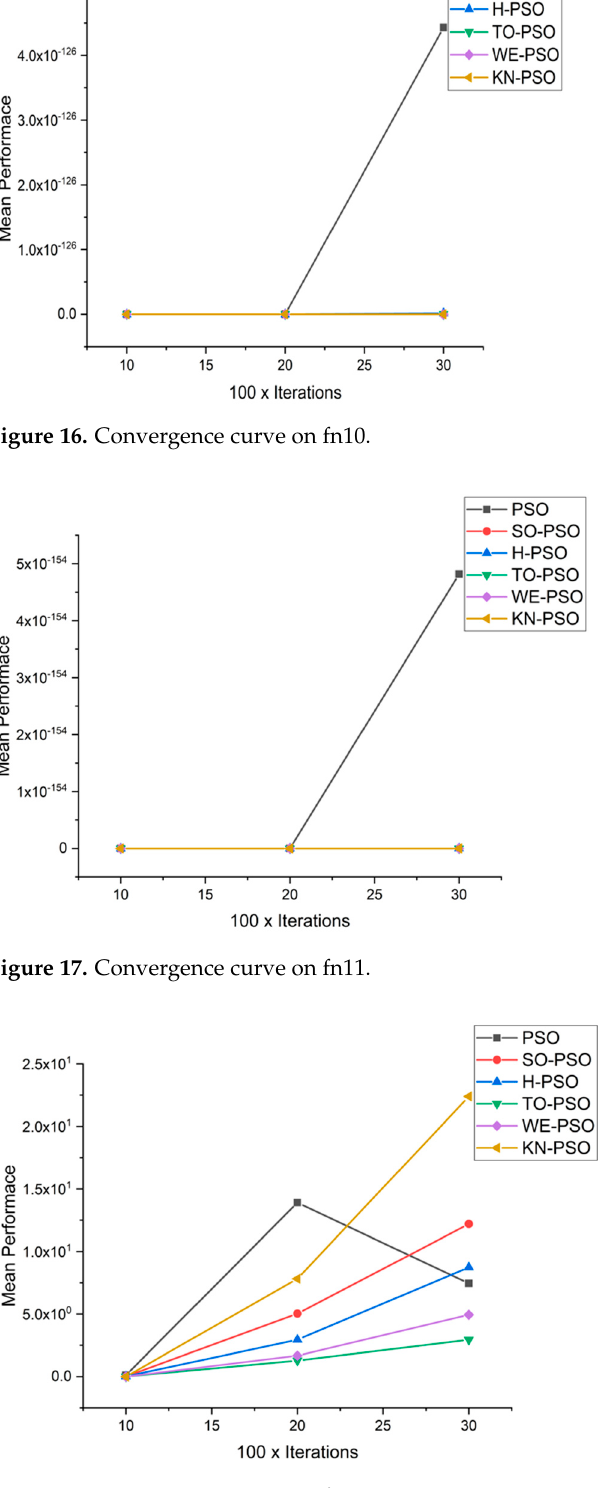
Figure 18. Convergence curve on fn12.